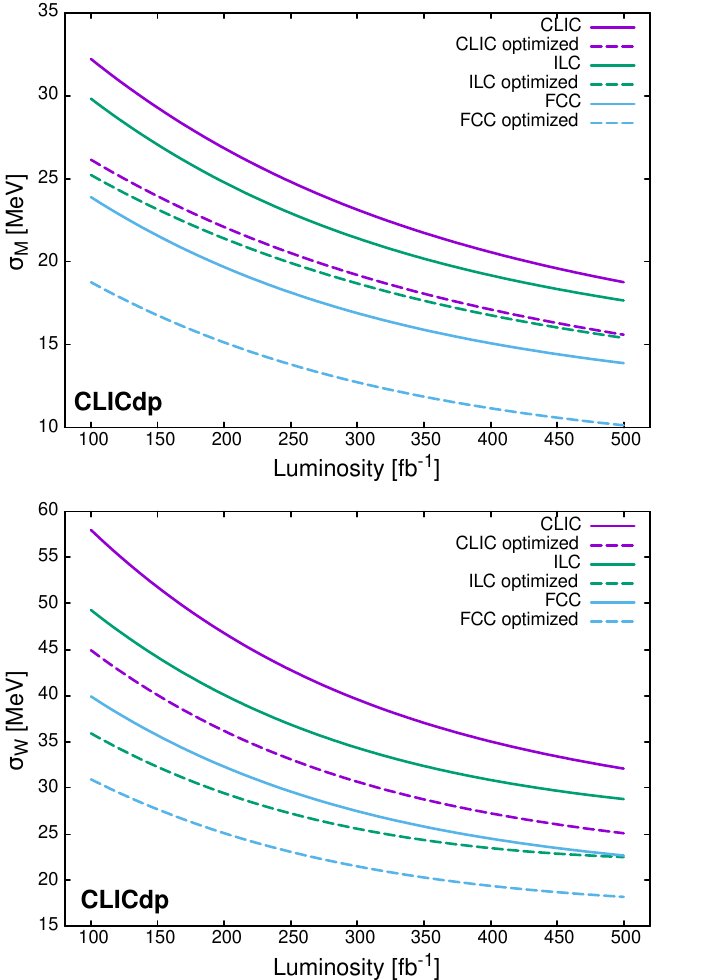
Figure 18 . Expected uncertainty on the top-quark mass (top) and width (botom) from the baseline scan scenario (solid lines) and from scenarios optimised for mass and width measurement (dashed lines), as a function of the total scan luminosity. CLIC results (magenta) are compared with results of the same analysis and optimisation procedure but assuming ILC (green) or FCCee (cyan) luminosity